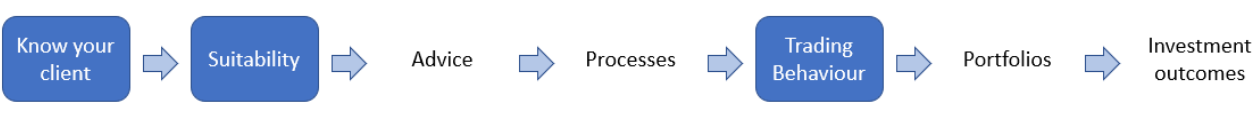
Figure 1. The downstream footprints of know your client (KYC)